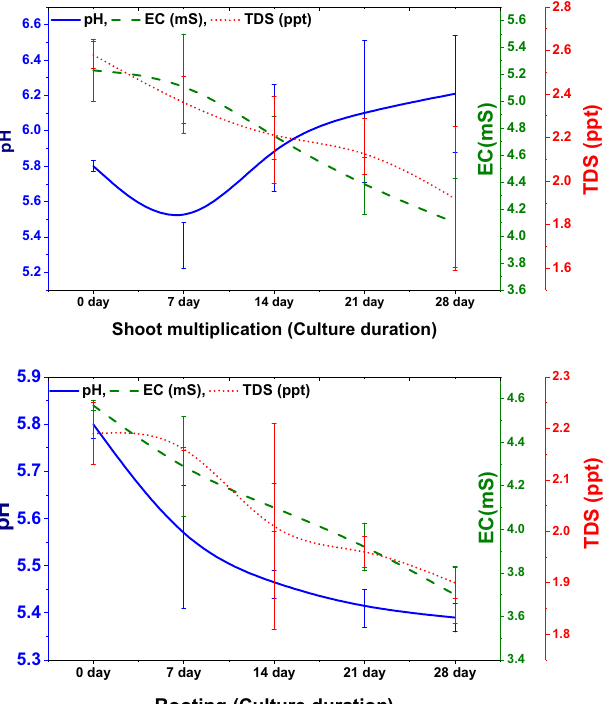
Figure 2. Physio-chemical changes in the media during the culture period in TIB (Graphs were generated using OriginLab Professional Version 2021b software; URL link: www. Origi nLab. com/ 2021b).